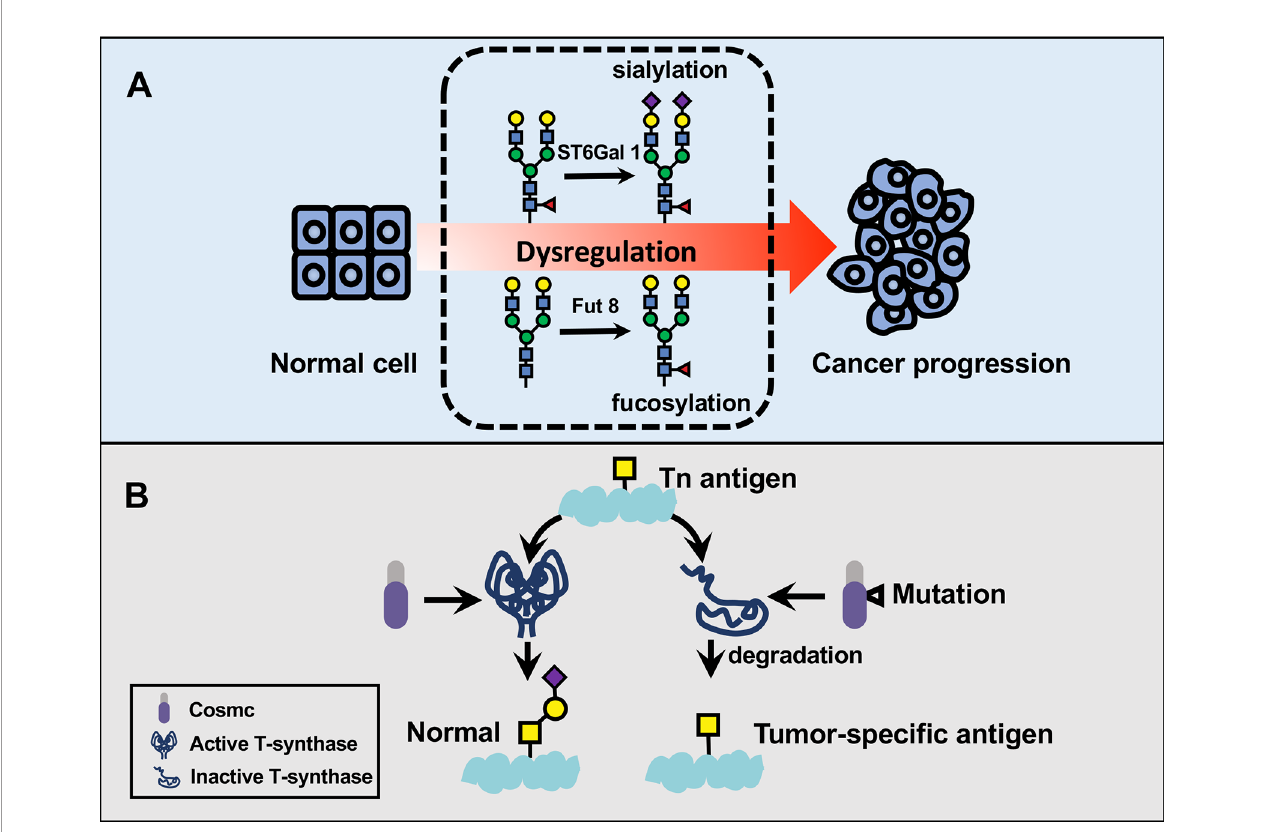
FIGURE 2 | The participation of dysregulated glycosylation in cervical cancer progression. (A) Glycans play fundamental parts in key pathological steps of tumor development and progression. a 2,6-sialyltransferase I (ST6Gal 1) and a 2,6-linked sialylation play fundamental parts in pathological steps of cancer progression. ST6Gal 1 attaches an a 2,6-linked sialic acid to Gal b 1,4GlcNAc usually via an a 2,6 linkage, thereby serving as a regulator in cervical cancer metastasis. Cervical cancer tissues also exhibit aberrant fucosylation in the cytosolic proteins compared to normal tissues. (B) Tn antigen is a major driving carbohydrate antigen in cervical squamous cell carcinoma. Cosmic is mostly known as an essential chaperone required for T-synthase activity, which can convert Tn antigen to a common precursor T antigen for further extension in the Golgi apparatus. In contrast, the somatic mutation in cosmic has been associated with a loss of T-synthase and subsequent accumulation of Tn antigen in cervical cancer